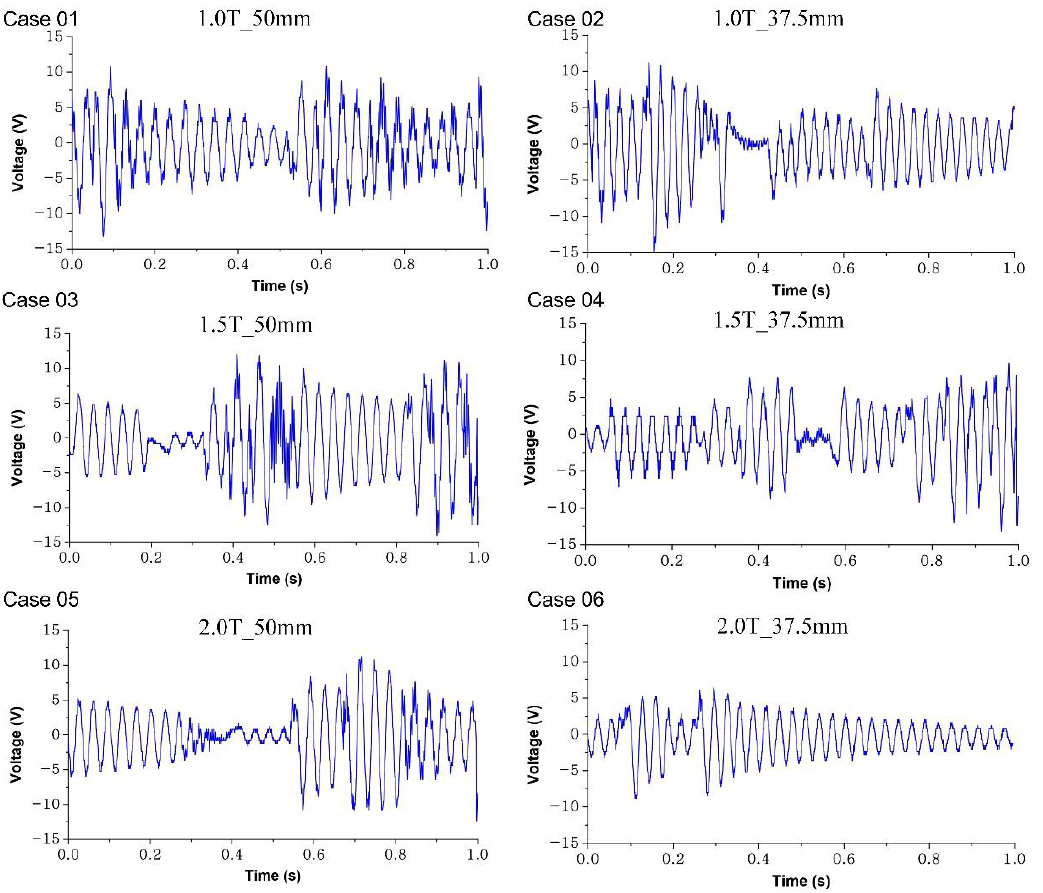
Figure 14. Measured open circuit output voltage of the PDPWEH in each case.